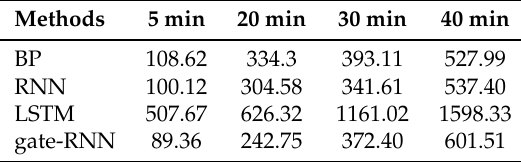
Table 9. Results of the MAE for different time scales.